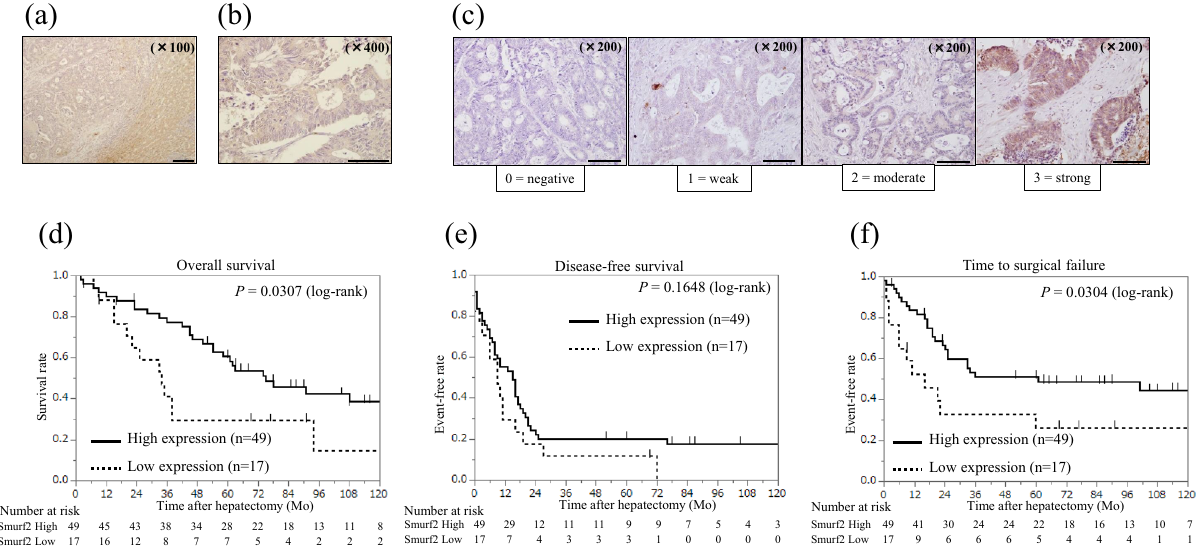
Figure 2. Smurf2 expression in colorectal liver metastases and the long-term outcome based on Smurf2 expression. Immunohistochemistry analysis for Smad ubiquitination regulatory factor 2 (Smurf 2) expression in ( a , b ) colorectal liver metastases. Scale bar = 200 µm ( a ) and 100 µm ( b ). ( c ) Representative images of each score evaluating Smurf2 expression in colorectal liver metastases. Scale bar = 200 µm ( c ). The Kaplan–Meier analysis for ( d ) overall survival, ( e ) disease-free survival, and ( f ) time to surgical failure based on the Smad ubiquitination regulatory factor 2 (Smurf 2) expression in metastatic liver